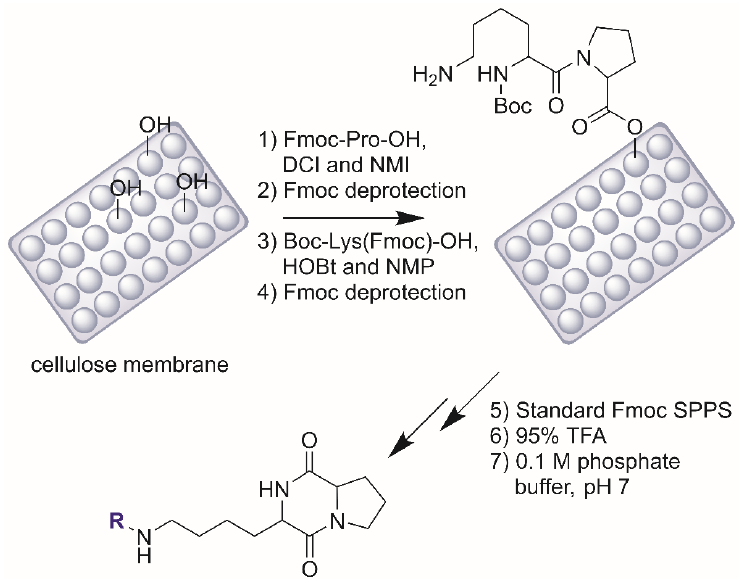
Scheme 2. CDP-array synthesis on cellulose membranes via SPOT method for rapid screening